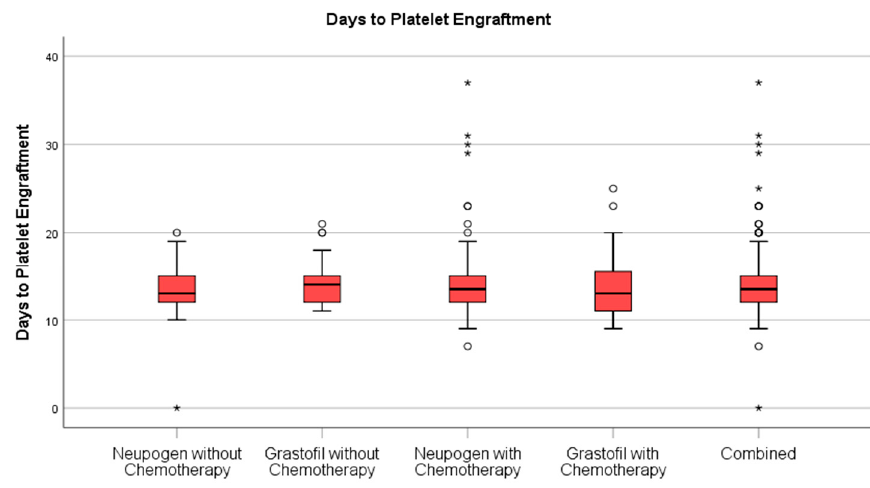
Figure 2. Days to platelet engraftment comparison for patients receiving Neupogen ® or Grastofil ® . * denotes extreme outlier.